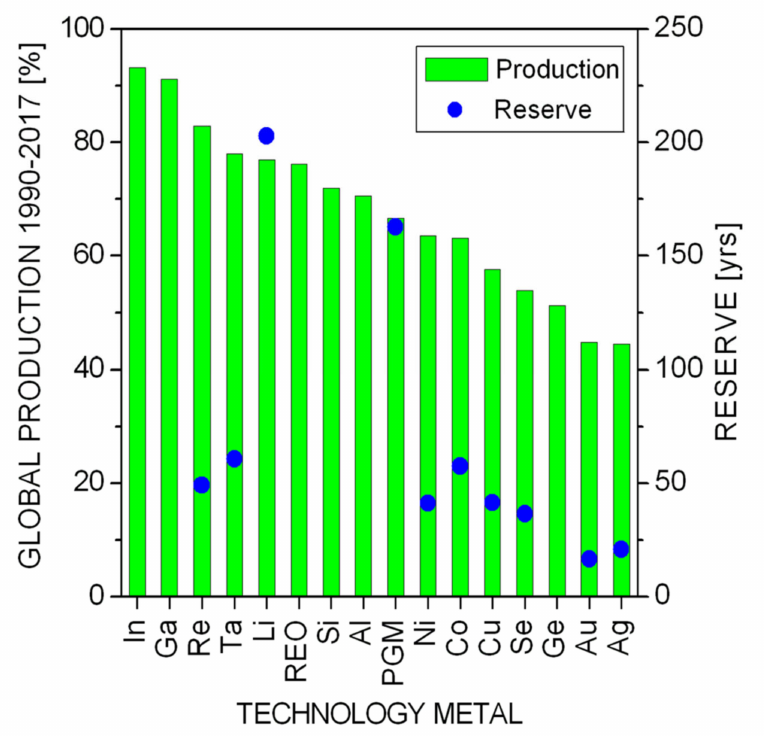
Figure 3. Global mine production of some technology metals in years 1990 to 2017 normalized to the production since 1900 (REO is rare earth oxide; PGM is platinum group metals including Pd, Pt, Ir, Os, Rh, and Ru; Si refers to silicon metal). Reserve calculated from known materials reserve and annual mine production. Data taken from